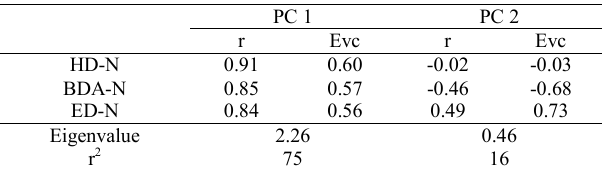
showed no separation between notochord and musculature (Fig. 4j, k) and starved larvae showed slight notochord shrinkage and separation with muscular trunk (Fig. 4l).